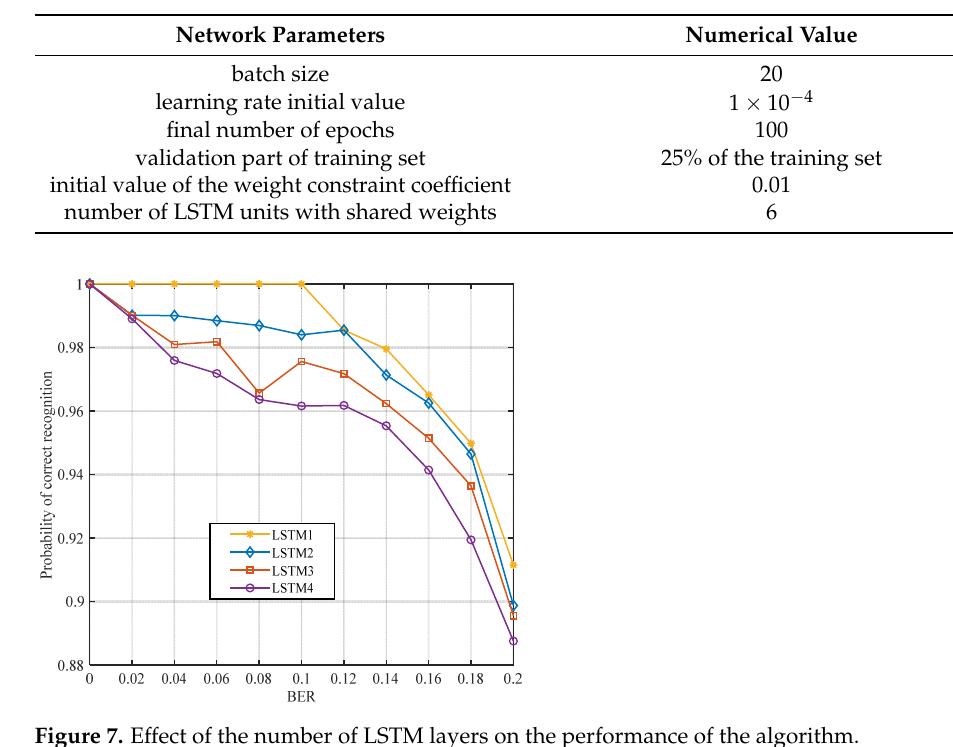
Table 3. Network model parameters.